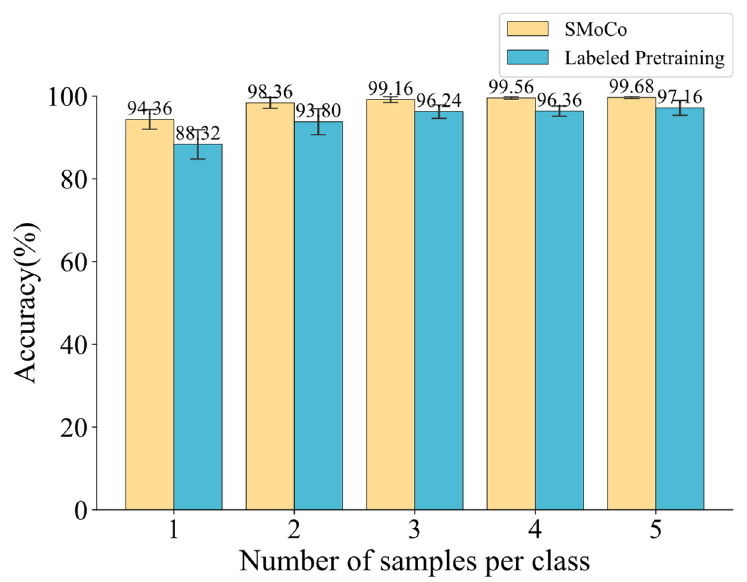
Figure 12. Comparison of results under different training set sizes on dataset 2.